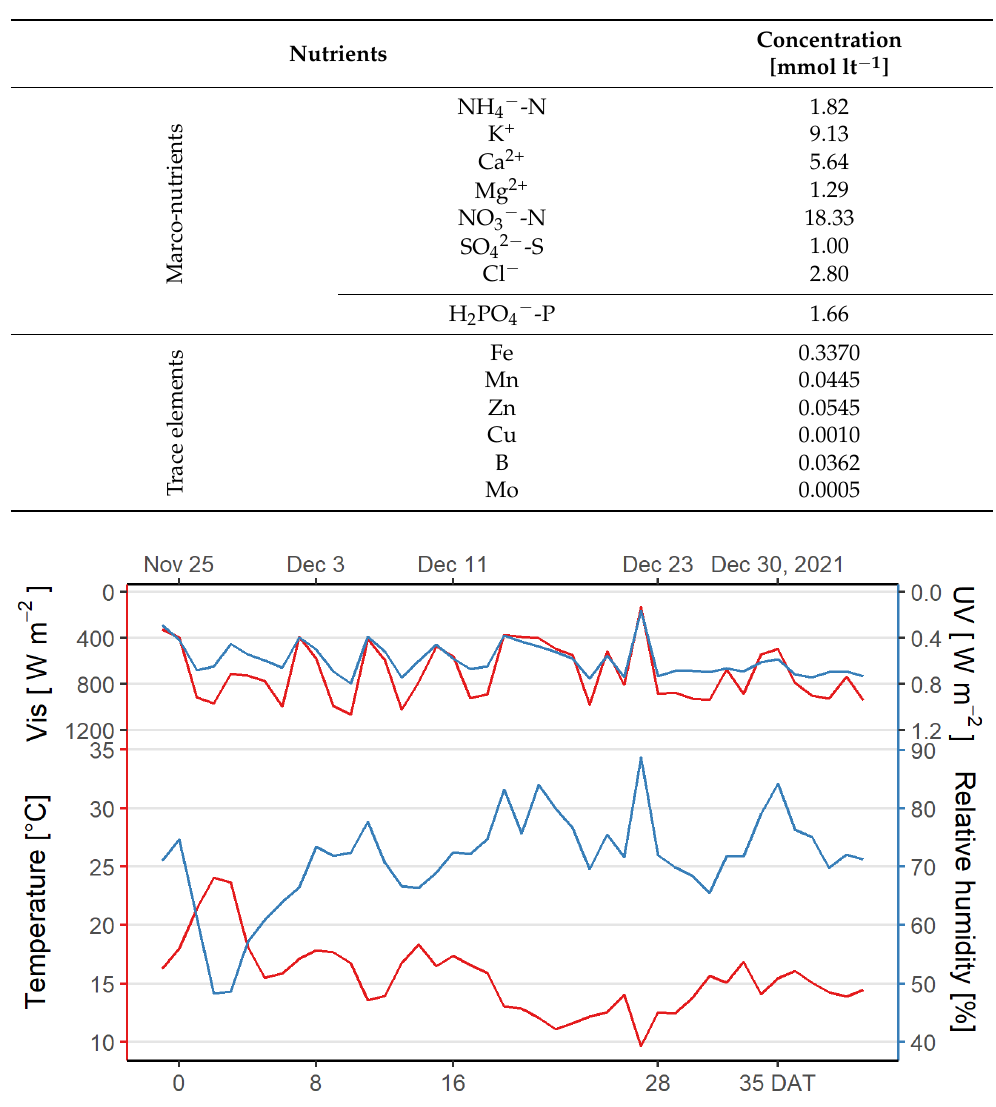
Figure 2. Mean daily air temperature T [ ◦ C], mean daily relative humidity RH [%], and mean daytime irradiance in the visible (Vis) and ultraviolet (UV) spectrum [W m − 2 ] during the cultivation.